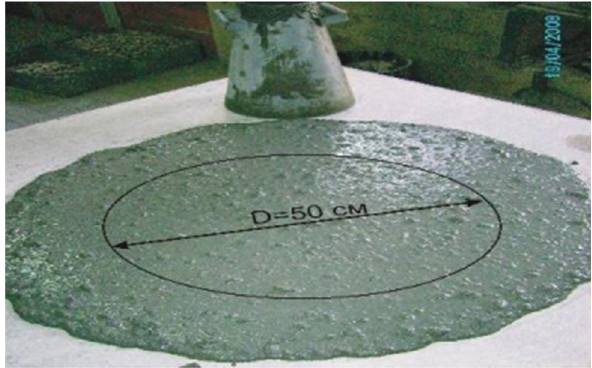
Figure 3: Determination of the fl owing time of the mixture ( slump fl ow time, T ) 500 , s